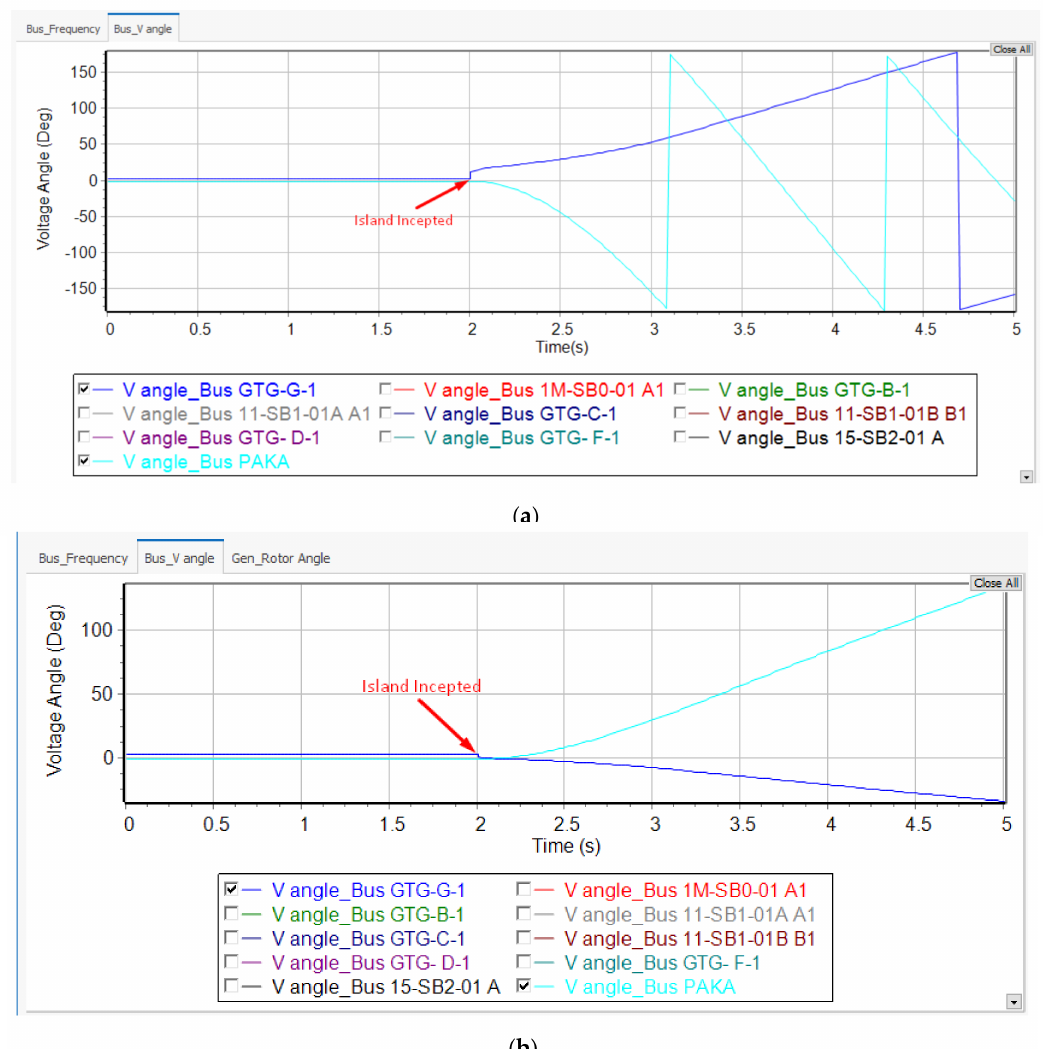
Figure 14. Island detection of the over frequency ( a ) and under frequency ( b ) conditions using the bus voltage angle